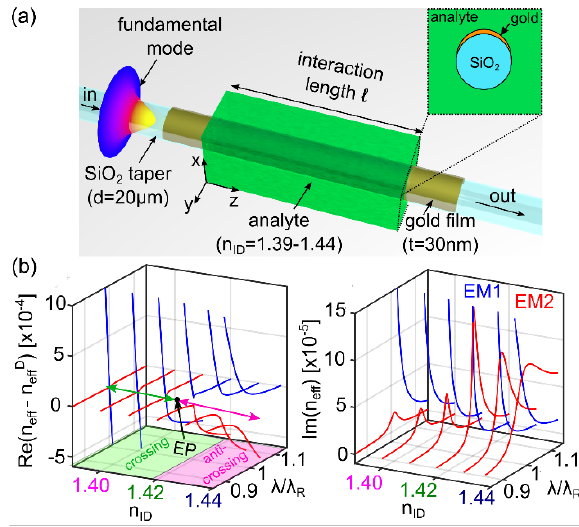
Fig. 1. (a) Hybrid fiber-plasmonic waveguide schematic. A silica fiber coated by a gold nanofilm is immersed in a liquid with RI of n ID and length ℓ. (b) Calculated spectral distribution of Re(n eff , j − n eff,D ) (j=1,2, n eff,D : equivalent dielectric waveguide without gold film) and Im(n eff ) for EM1 and EM2 as a function of λ/λ